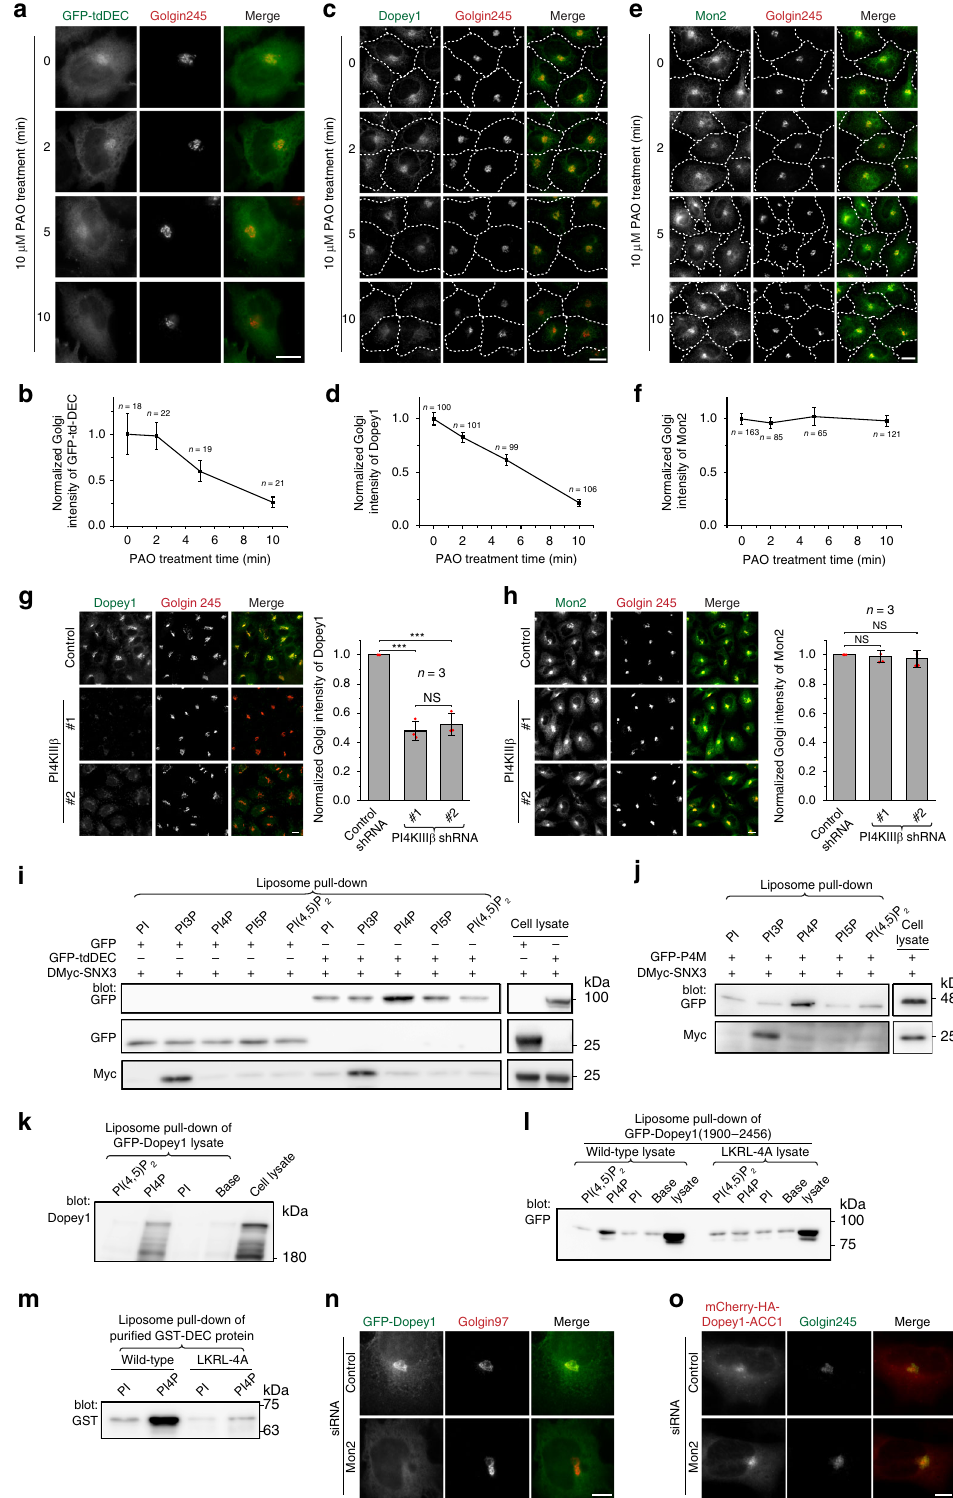
required for Dopey1 to co-IP Kif5b (Supplementary Fig. 5a), therefore suggesting that Dopey1 probably interacts with Kif5b indirectly via KLC2. Serial truncations of Dopey1 revealed that the N-terminal region consisting of ~150 residues, which was referred to as Dopey1 extreme N-terminal region (DEN), is necessary and suf fi cient to interact with co-expressed KLC2 (Fig. 5b